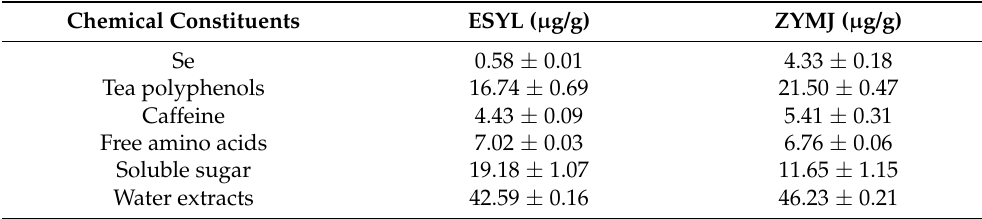
Table 1. Comparison of the main components of ESYL and ZYMJ ( µ g/g). Chemical